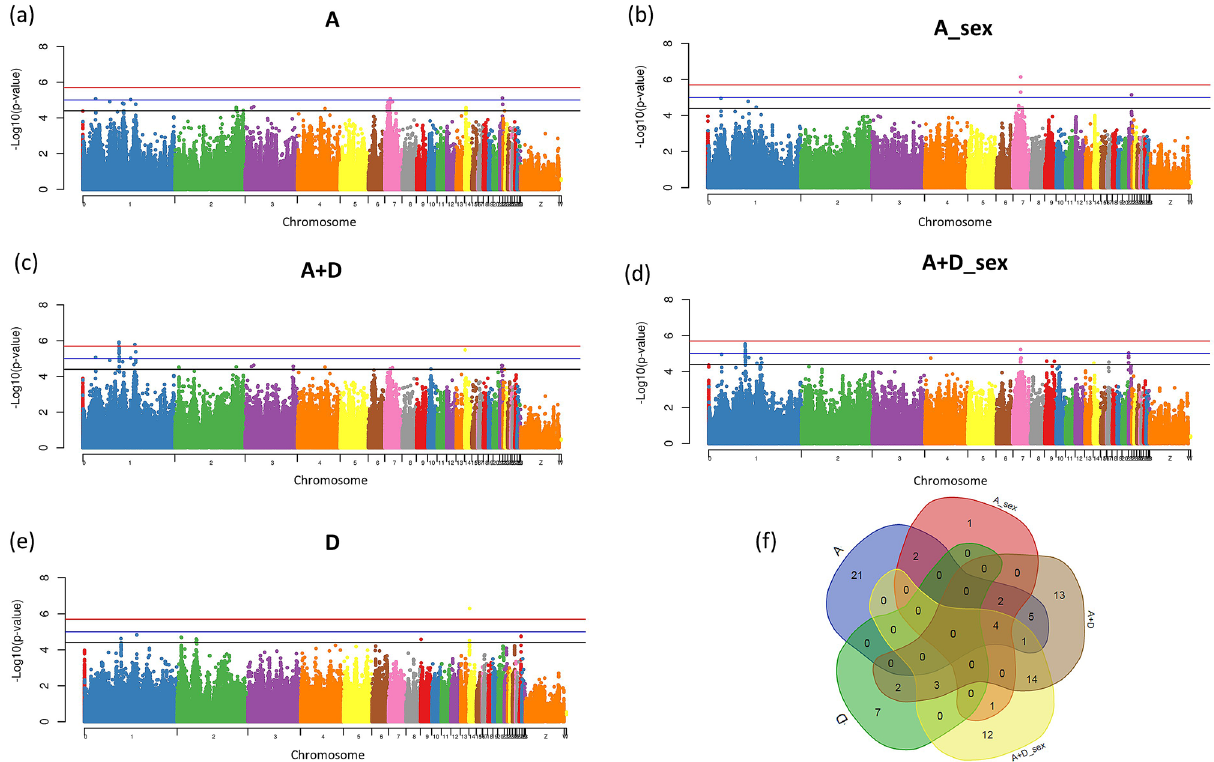
Figure 1. Manhattan plots of genome-wide association study for feed intake (FI). The Manhattan plot indicates the -log10 (p-values) for genome-wide SNPs (y-axis) plotted against their respective positions on each chromosome (x-axis). The horizontal red, blue and black lines indicate the 5% genome-wide significant (4 × 10 – 6 ), moderate (1 × 10 –5 ) and suggestive (4 × 10 –5 ) thresholds, respectively. The Manhattan plots are presented fitting five different SNP effects in the model: ( a ) additive effect (A); ( b ) additive fit in each sex (A_sex); ( c ) additive plus dominance (A + D); ( d ) additive plus dominance fit in each sex (A + D_sex); ( e ) dominance (D). The ( f ) is a Venn diagram summarizing the number of significant SNPs identified when each different SNP effect was fit in the model. The Venn diagram was constructed using a Bioinformatics and Evolutionary Genomics tool available in http://bioin forma tics.psb.ugent .be/webto